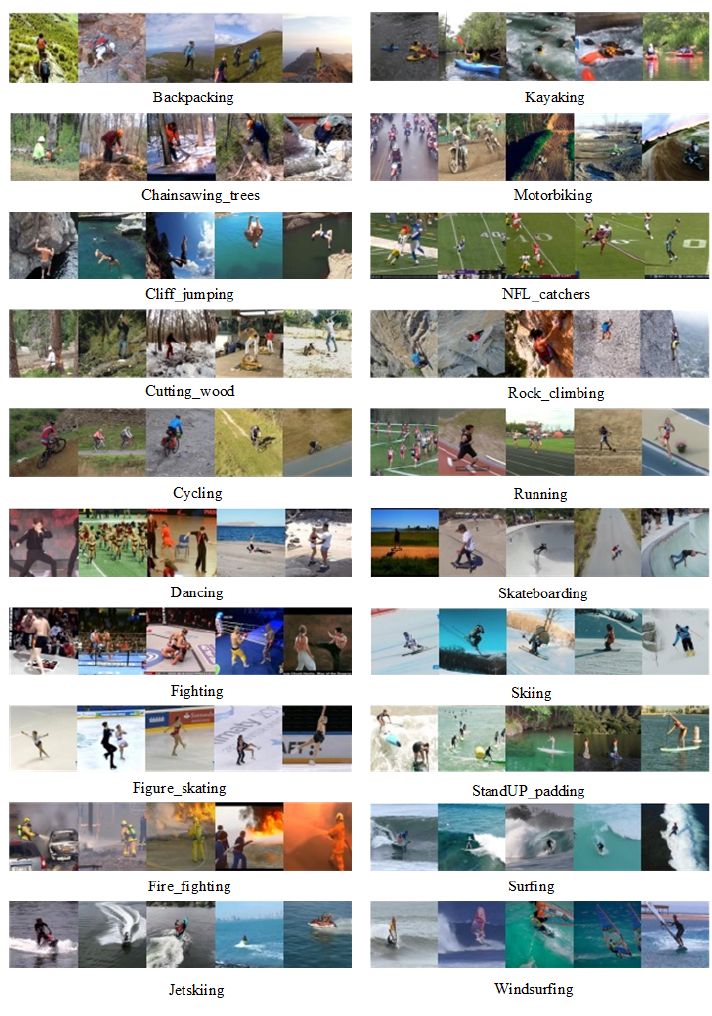
Figure 8. The example of the MOD20 dataset